Question: Looking at the figure, what chart type is it?
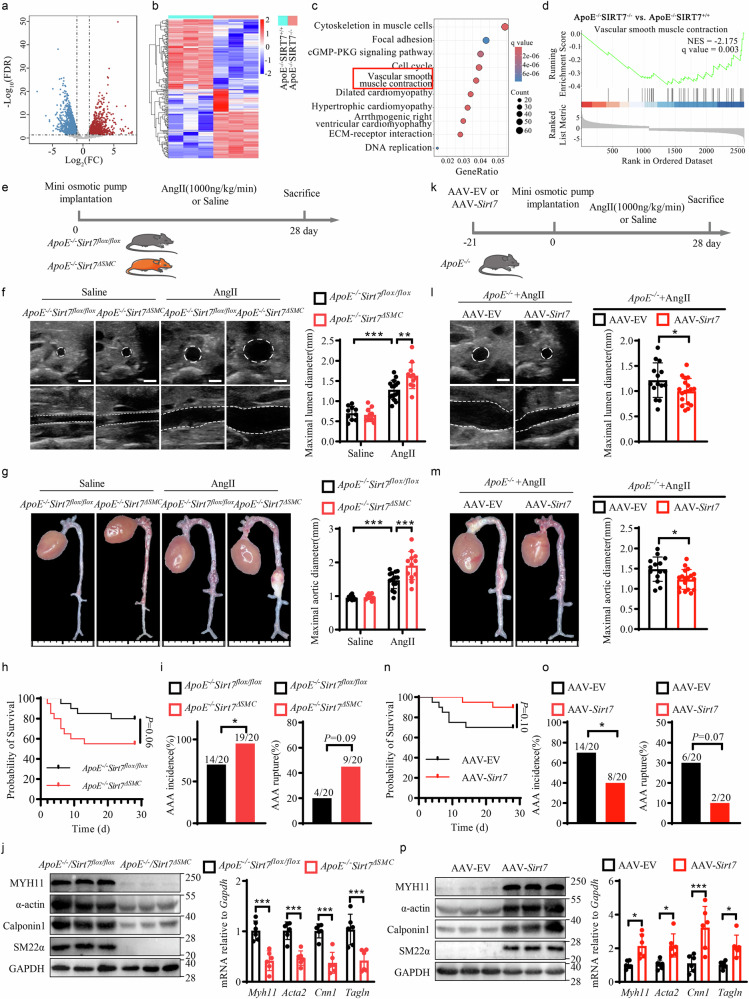
Answer: heatmap